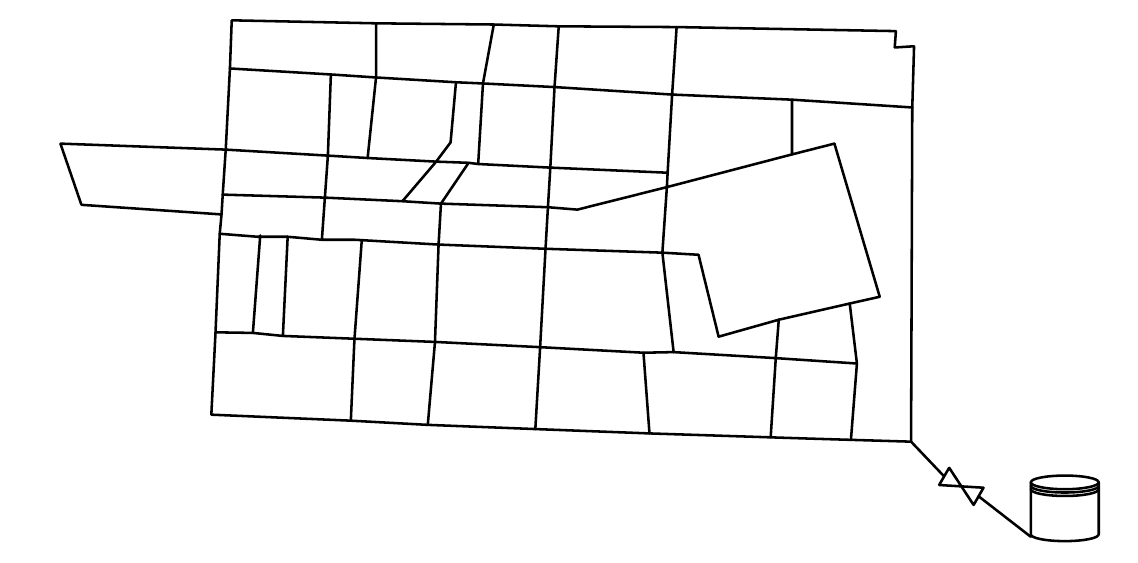
Figure 3. Schematic of the network of Baharestan.